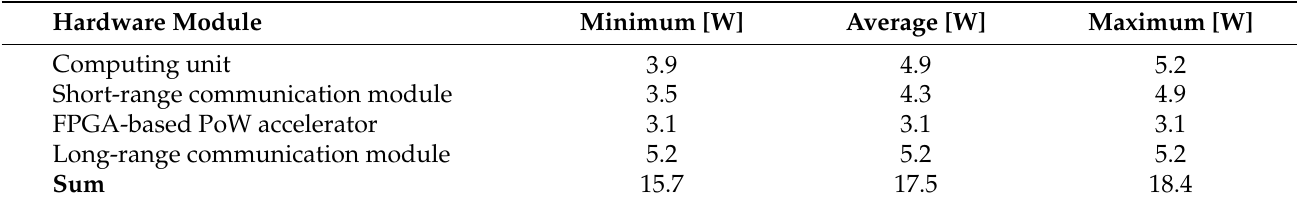
Table 3. Electric power consumption of different hardware modules used by the car in Watts